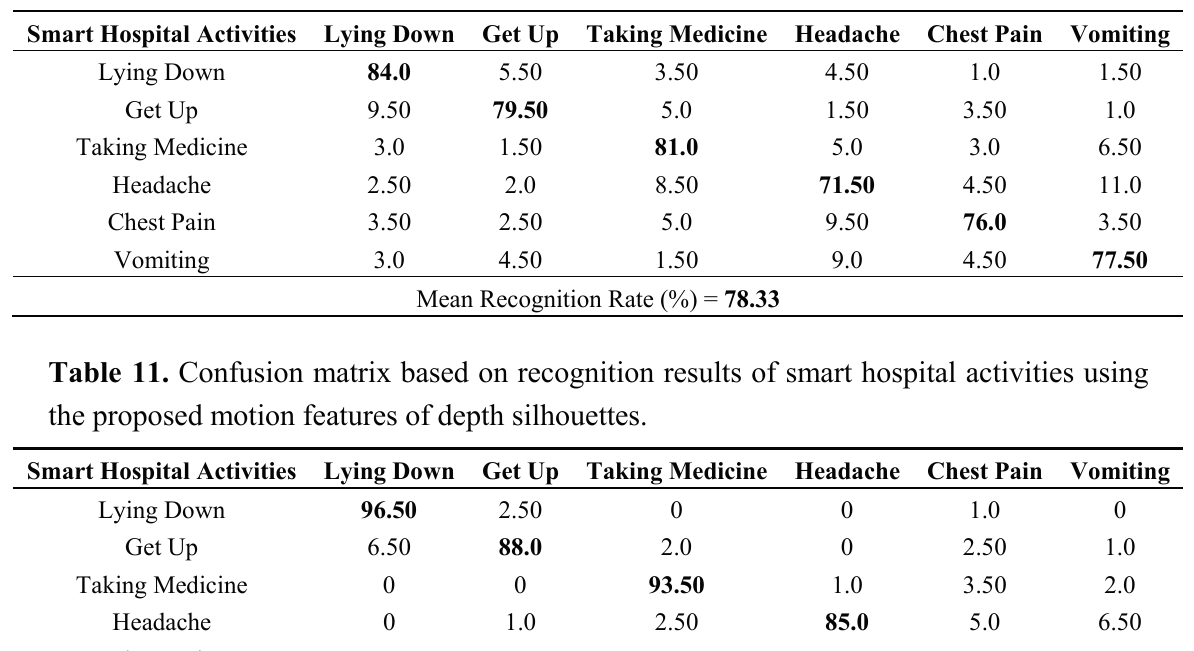
Table 10. Confusion matrix based on recognition results of smart hospital activities using IC features of depth silhouettes.